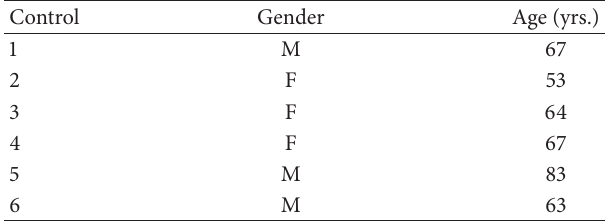
Table 2: Characteristics of control corneas. Control Gender Age